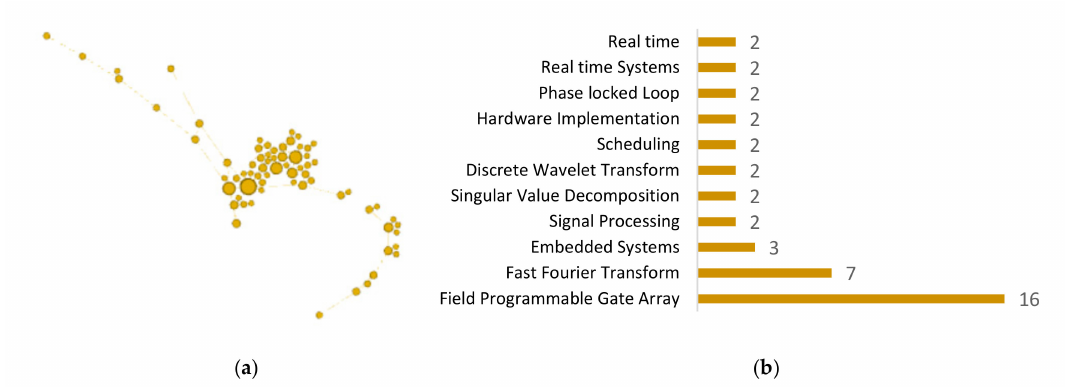
Figure 16. Representation of the Digital Processing community: ( a ) Isolated distribution of publications. ( b ) Keywords of the